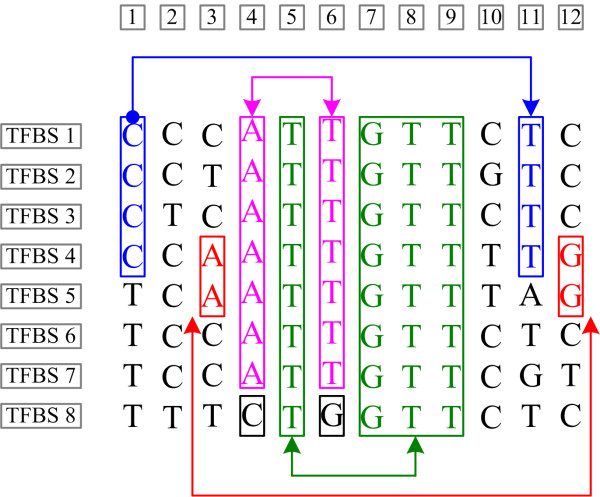
Example of positive correlations. The bases in the rectangles connected by the link are positively correlated. These eight known rox1 binding sites were taken from the promoter database of Saccharomyces cerevisiae.